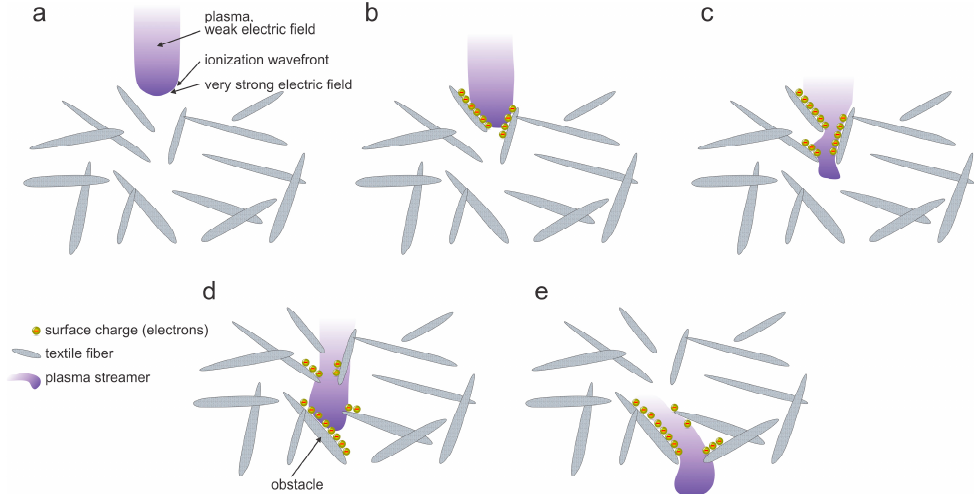
Figure 8. Illustration of a streamer penetration inside the textile and propagation through textile fibers from ( a ) to ( e ).